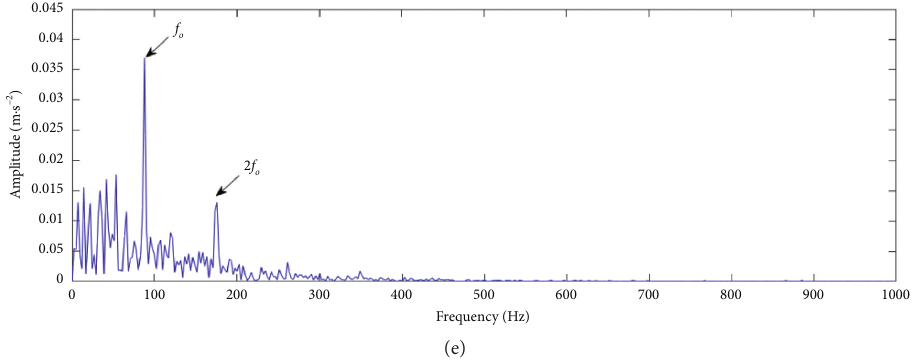
Figure 18: Analysis results of compound fault signal. (a) The modes obtained by the improved VMD method. (b) SPRI indexes of IMF components. (c) SPRO indexes of IMF components. (d) Envelope spectrum of IMF1 component. (e) Envelope spectrum of IMF6 component.